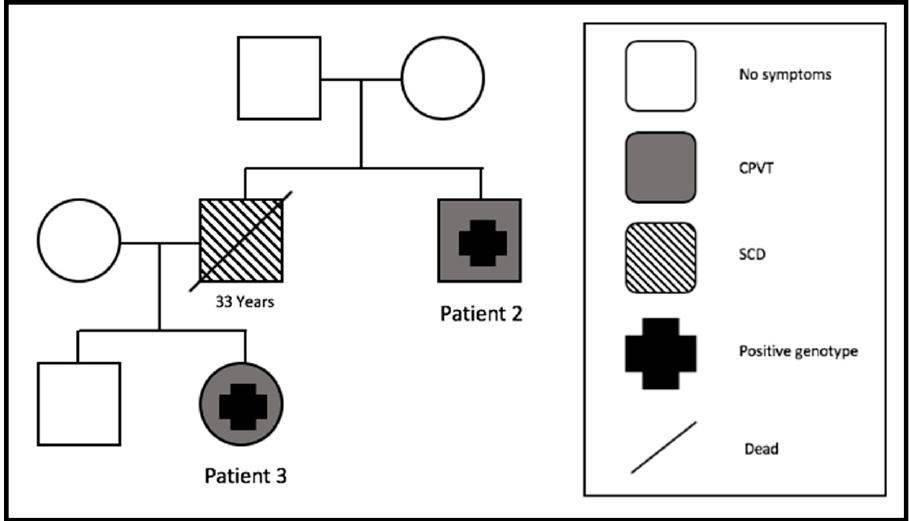
Figure 1. Pedigree of family 2. One SCD at the age of 33 years (SCD = sudden cardiac death). CPVT = catecholaminergic polymorphic ventricular tachycardia.